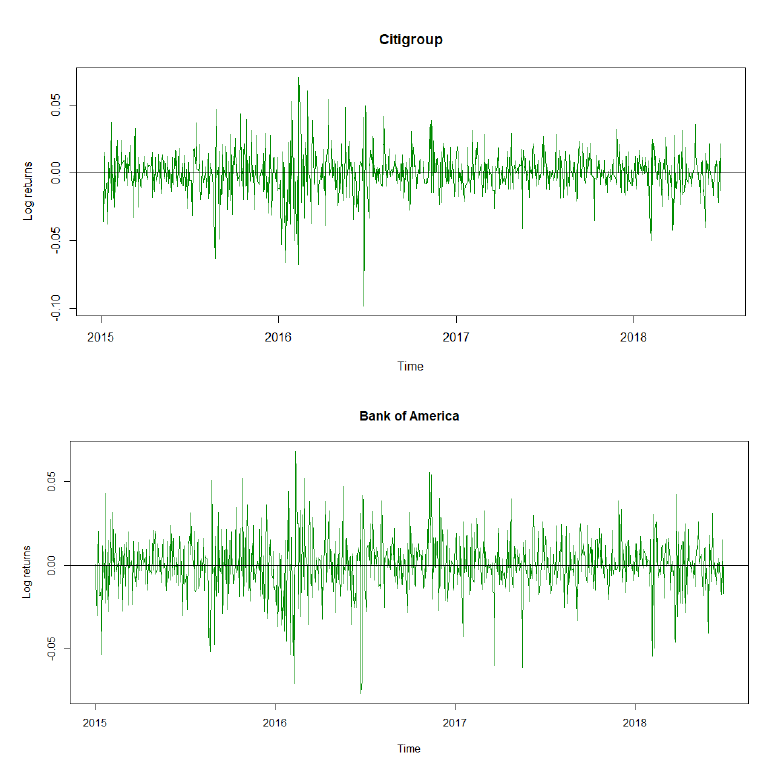
Figure 2: Daily equity log